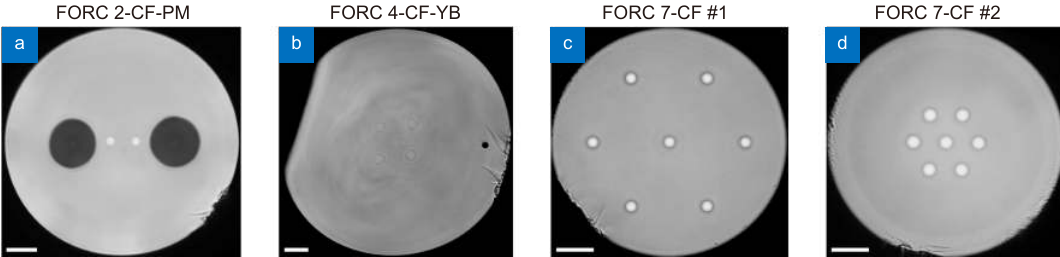
Fig. 2 | Microphotographs of different type MCFs manufactured by E.M. Dianov Fiber Optics Research Center. The scale bar corres- ponds to 20